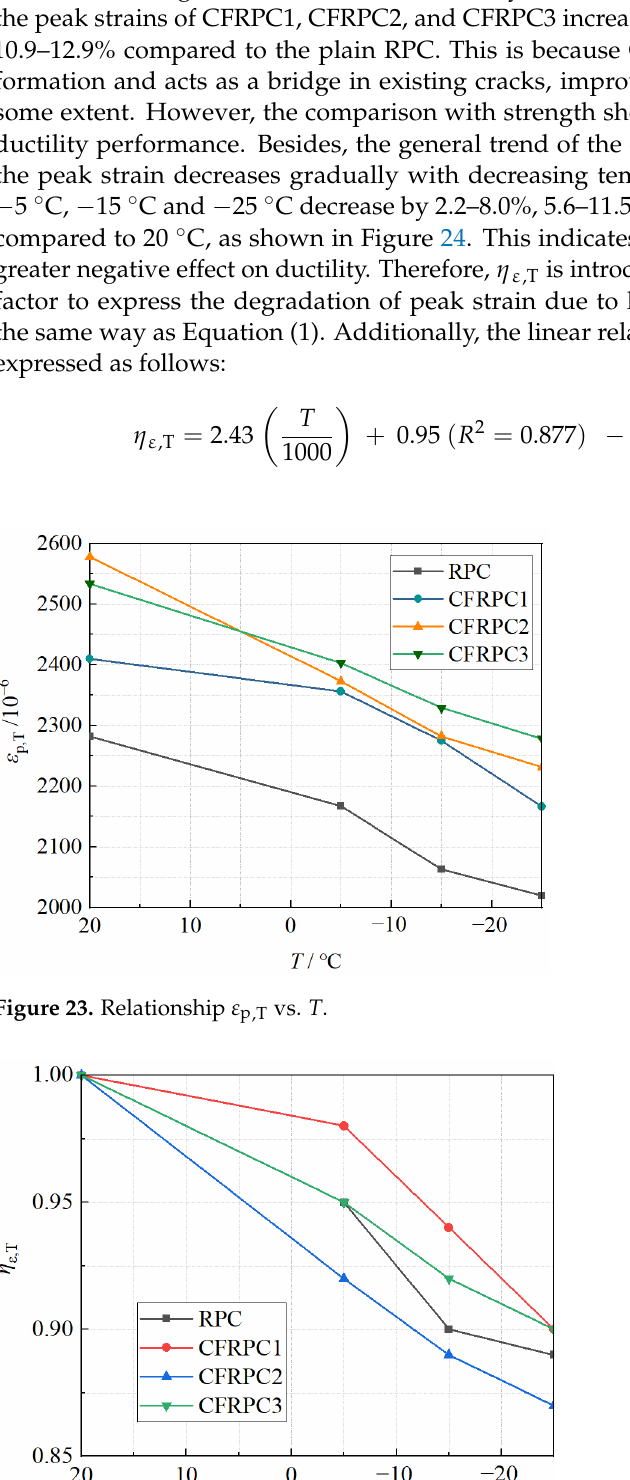
Figure 24. Relationship η ε ,T vs. T.